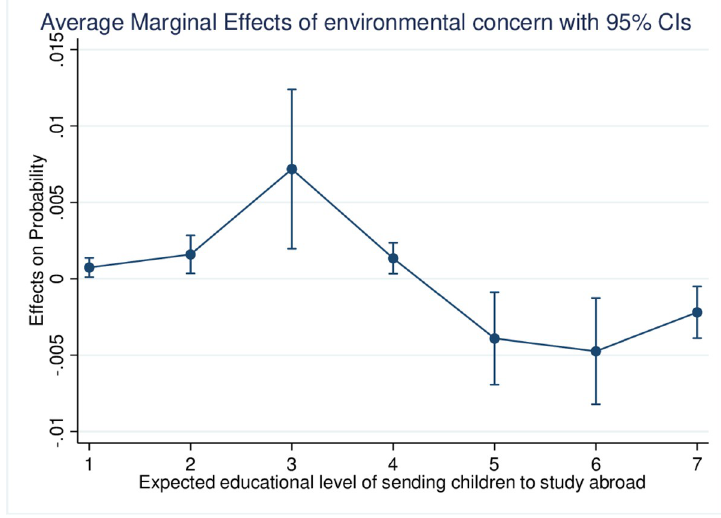
Fig 2. Probability of the expected educational level of sending children to study abroad according to environmental concern.